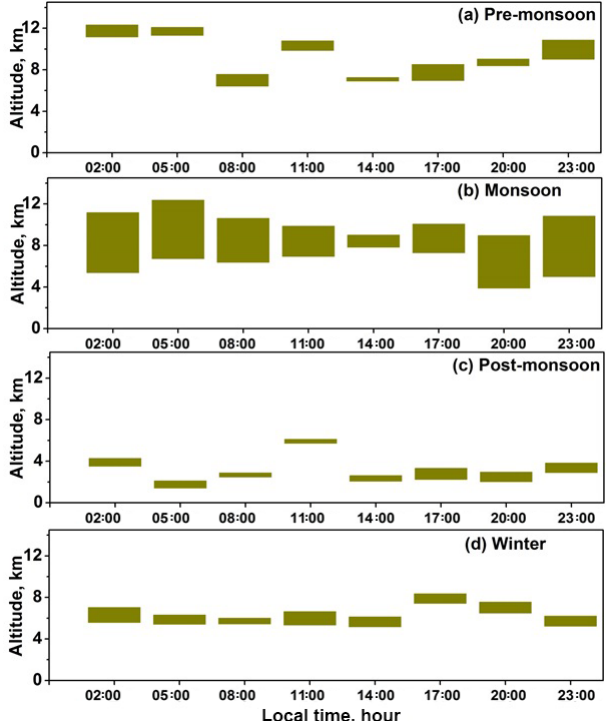
Figure 7. Diurnal variations of mean vertical locations (base and top) and thicknesses of two-layer clouds observed during (a) pre- monsoon, (b) monsoon, (c) post-monsoon, and (d) winter